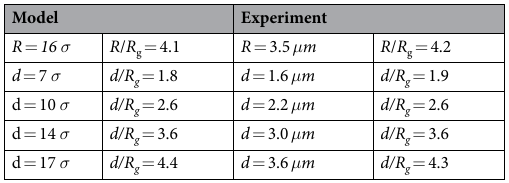
Table 2. Model gap sizes and post